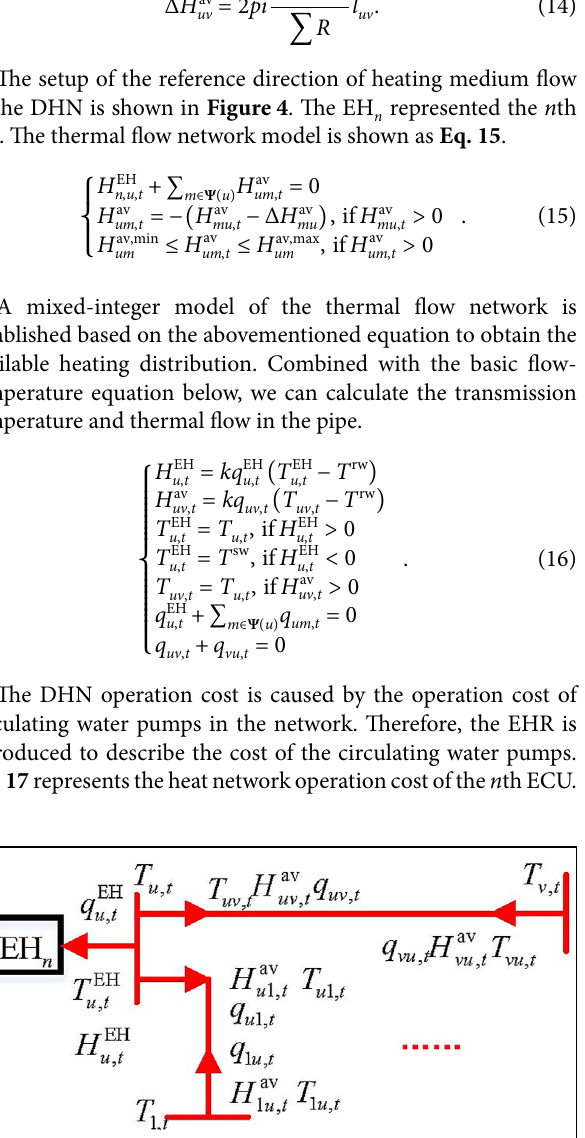
FIGURE 4 | Direction of heating medium flow in the